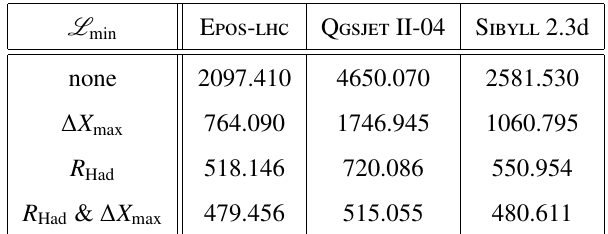
Table 1: Minimal values of the Likelihood-ratio expression from Eq.(3) for the best fits of three hadronic interaction models allowing di ff erent adjustments to the MC